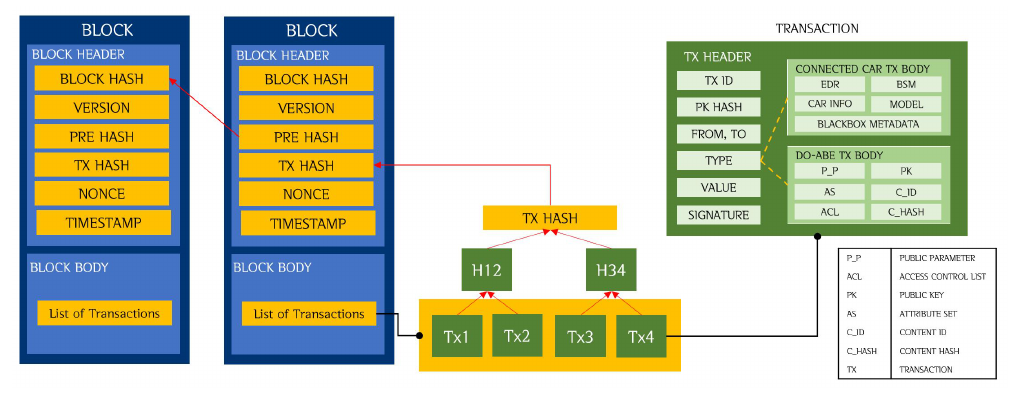
Figure 4. Block and transaction